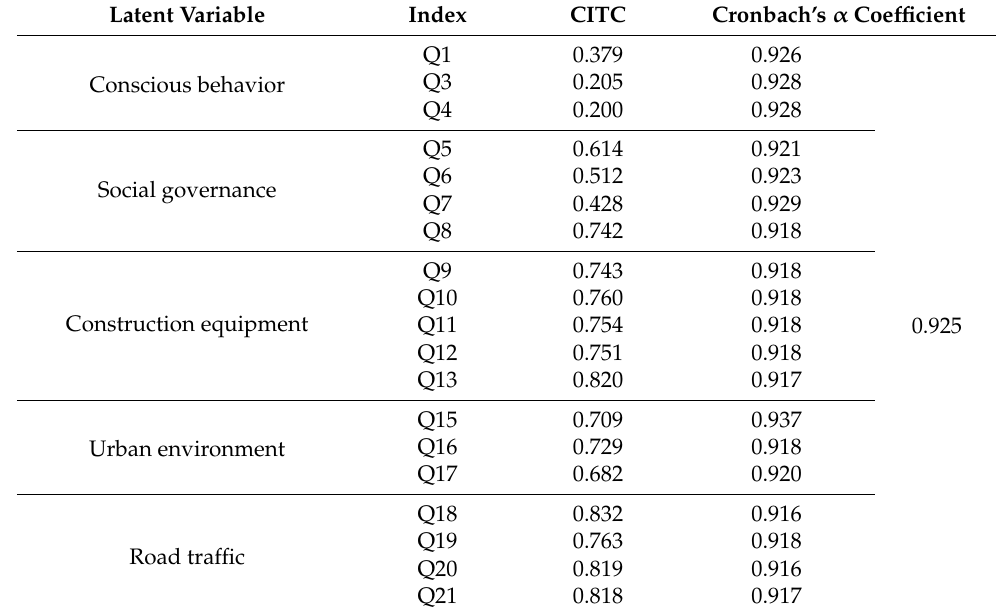
Table 5. Reliability analysis of 19 indexes.